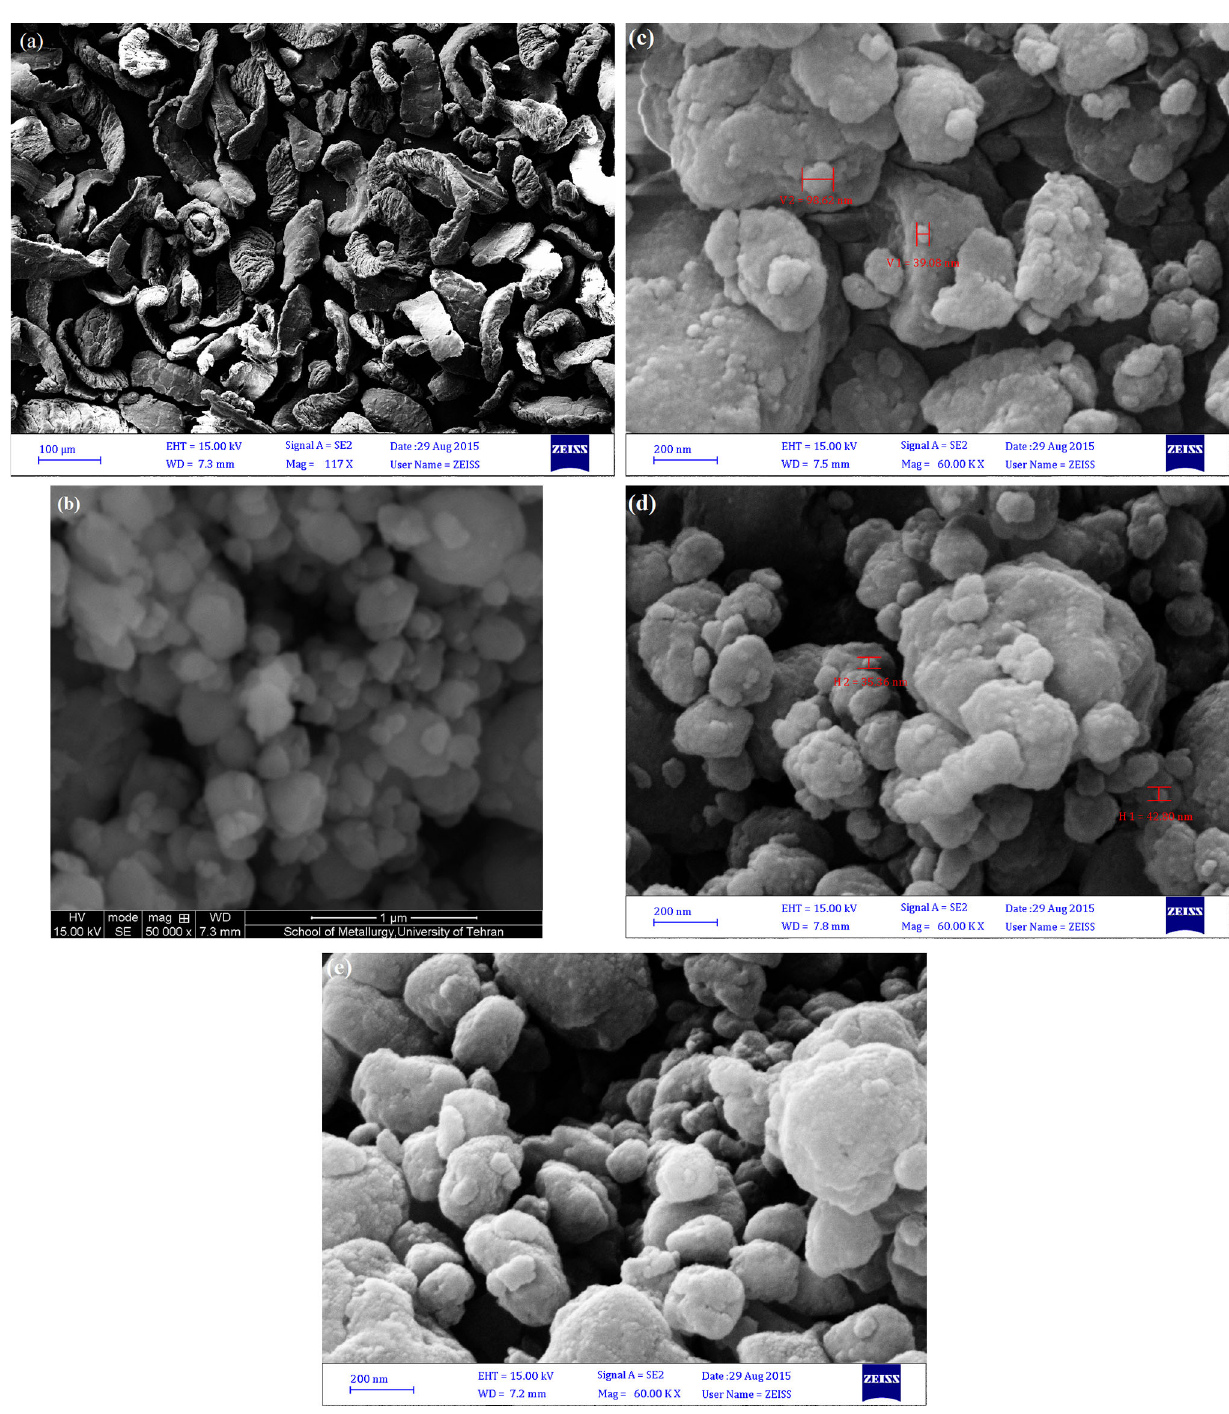
Fig. 2 FESEM images of a as-received MgH 2 , b BMM, c MN, d MT and e MN50T50